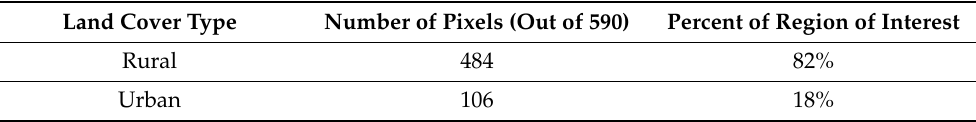
Table A2. Urban land cover delineation across the full study area (10 km radius) based on CORINE 2012 dataset. After resampling the classification to match the DMSP-OLS dataset, “urban” was assigned to any pixel with ≥ 50% urban cover. The final number of pixels assigned to urban and rural were totaled to estimate the percentage of the study region comprised of urban and rural land